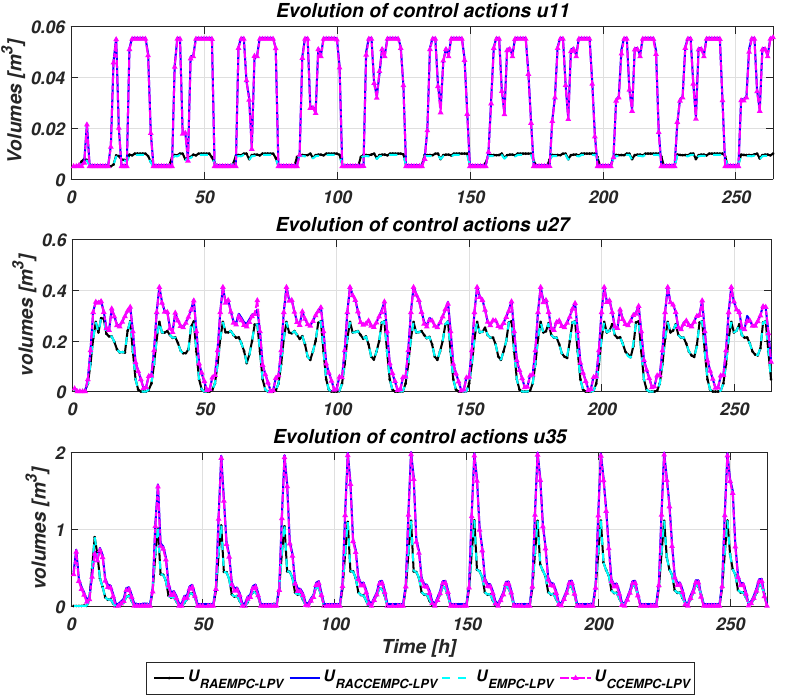
Figure 5. Evaluation of the control actions results.